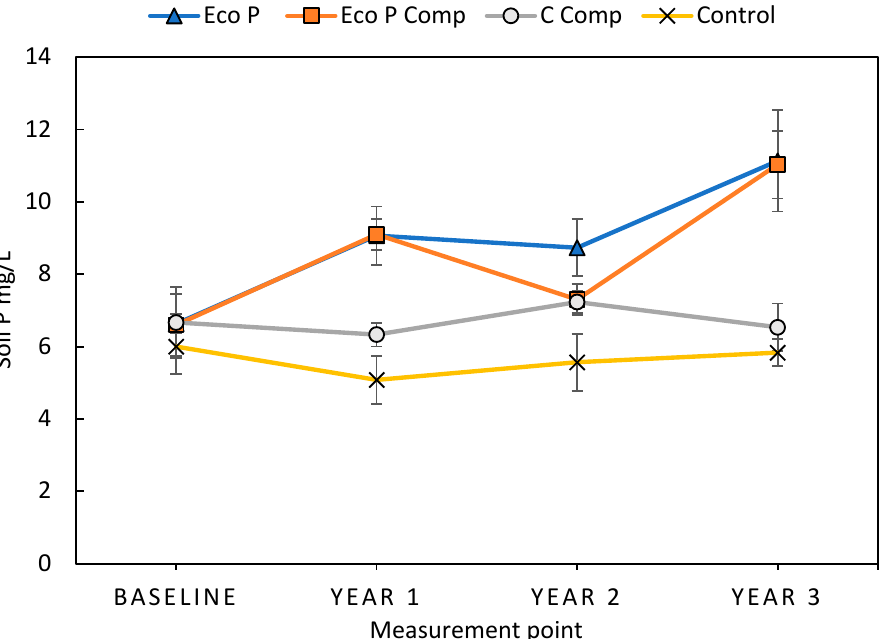
Figure 8. Soil P content comparing fertiliser test cases over the full duration of the field trial; error bars indicate standard error.